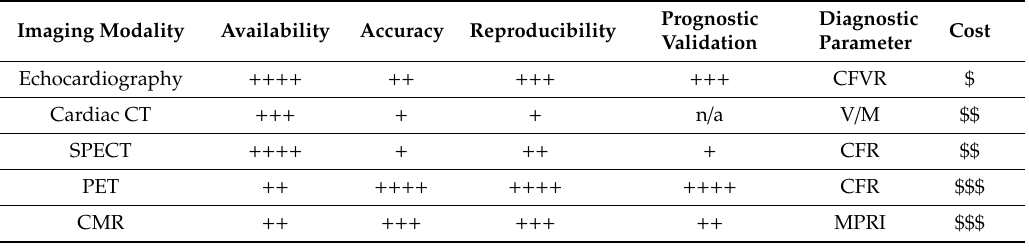
Table 1. Strengths and limitations of the various common noninvasive modalities for the diagnosis of